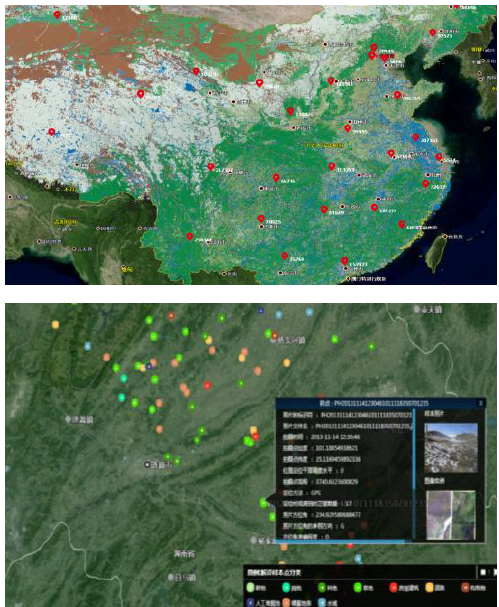
Figure 4. The spatial distribution of the RSAIS data and photo sample in three-dimensional display